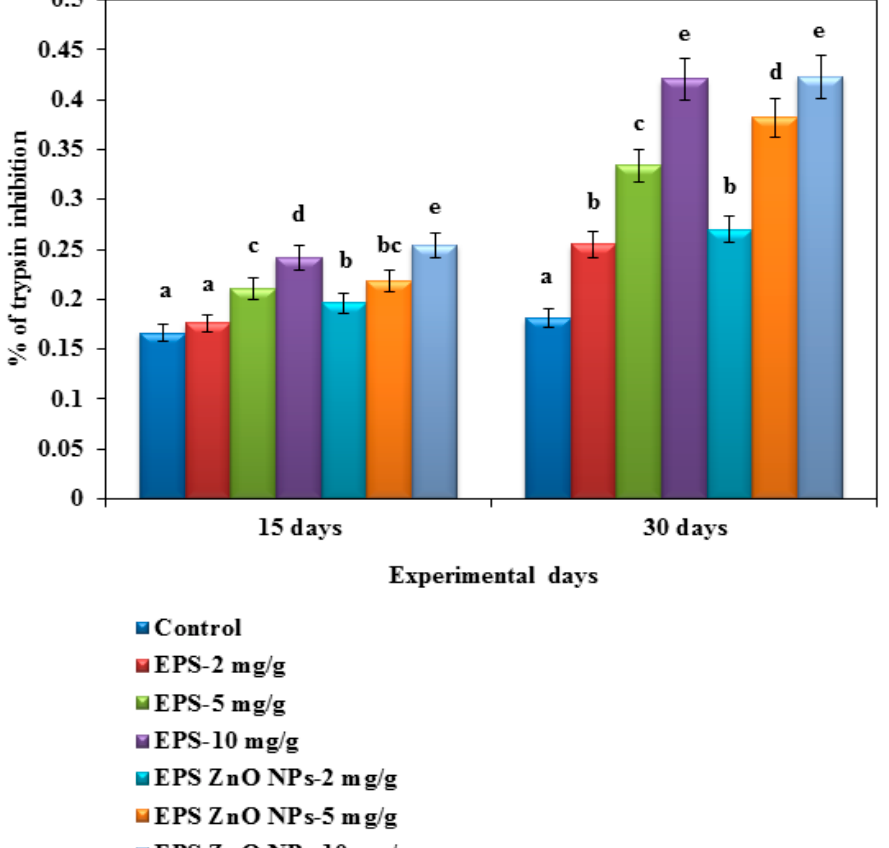
Figure 4. Antiprotease activity of O. mossambicus fed with EPS and EPS-ZnO NPs. T-bars indicate three replicates of mean ± SD, and different letters correspond to the statistical difference between treated groups.